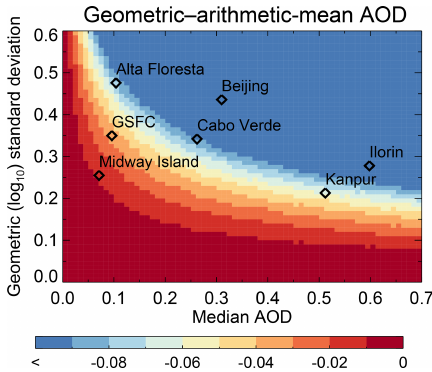
Figure 2. Difference between geometric- and arithmetic-mean AOD ( ¯ τ l − ¯ τ n ) as a function of median (equivalent to geometric mean) AOD and geometric standard deviation for log-normally dis- tributed data. Diamonds indicate the median AOD and geometric standard deviation (calculated over all direct Sun data) found at as- sorted AERONET sites which have been well-used in the